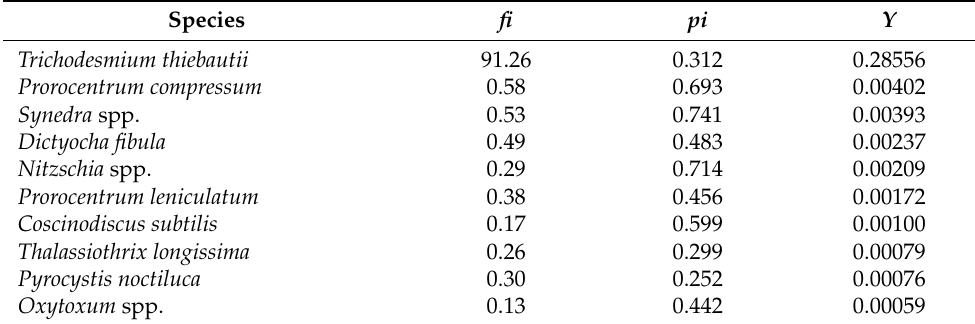
Table 1. Dominant species in the eastern Indian Ocean in spring